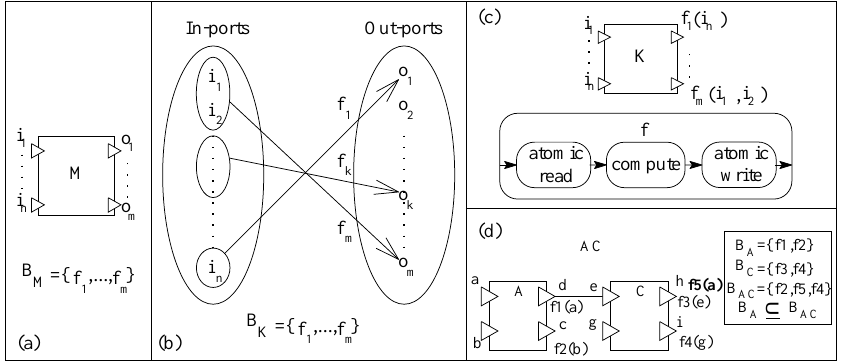
Figure 13. ( a ) A filter component, ( b ) Port relations, ( c ) Execution semantics, and ( d ) a